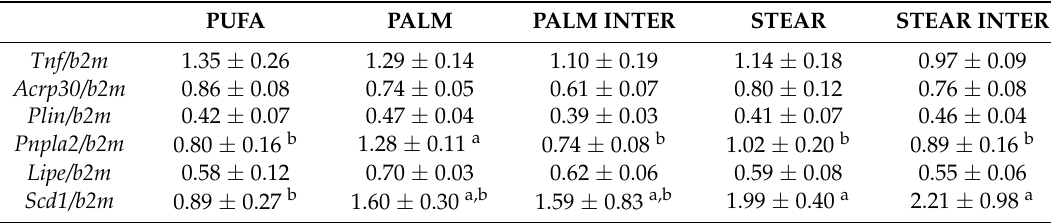
Table 4. Adipose tissue mRNA related to inflammatory and metabolic pathways of LDLr-KO mice fed experimental diets for 16 weeks. PUFA PALM PALM INTER